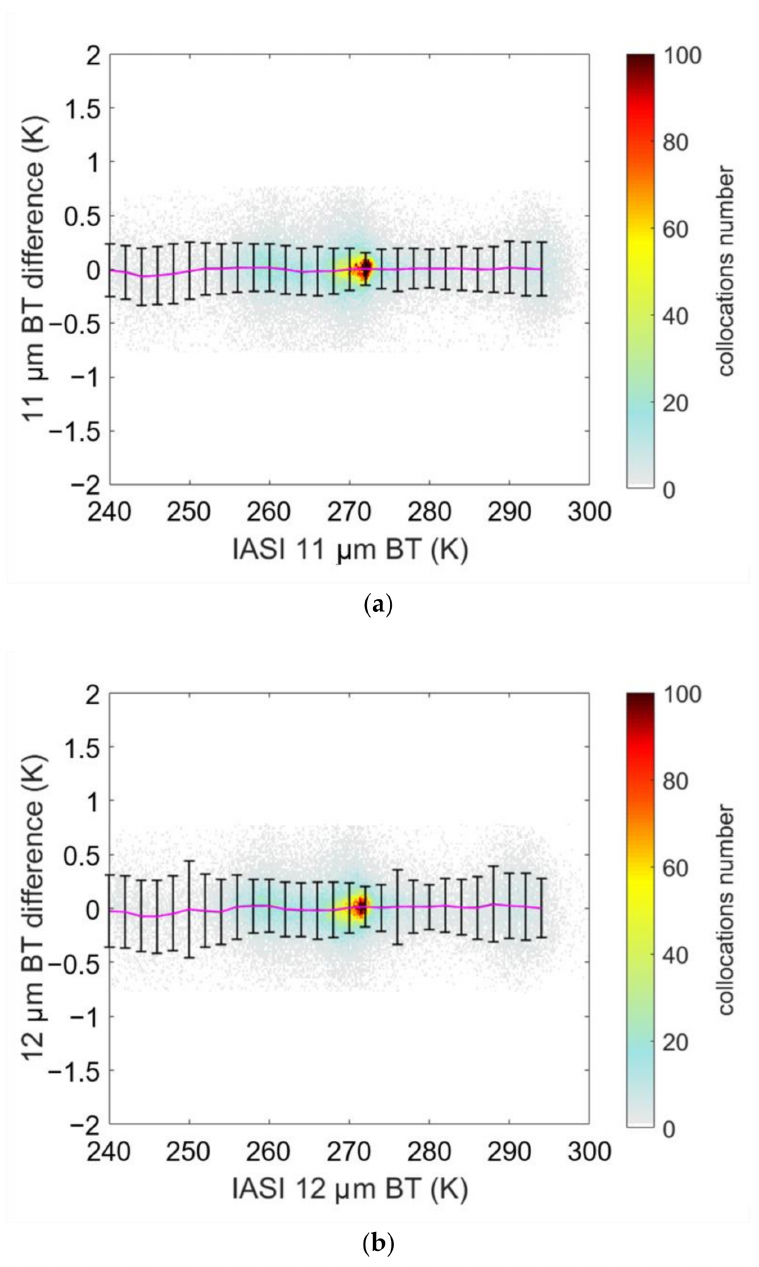
Figure 11. The variations in the COCTS-corrected BT minus IASI BT differences against the IASI BTs for the ( a ) 11 and ( b ) 12 µ m